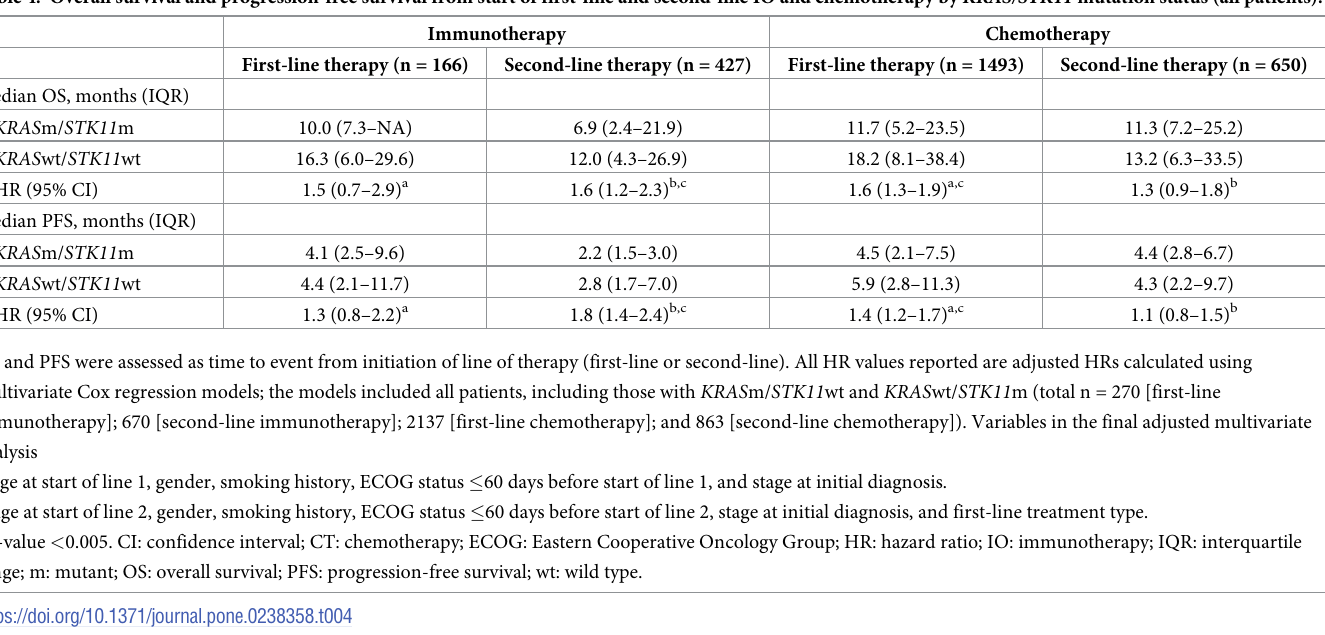
Table 4. Overall survival and progression-free survival from start of first-line and second-line IO and chemotherapy by KRAS/STK11 mutation status (all